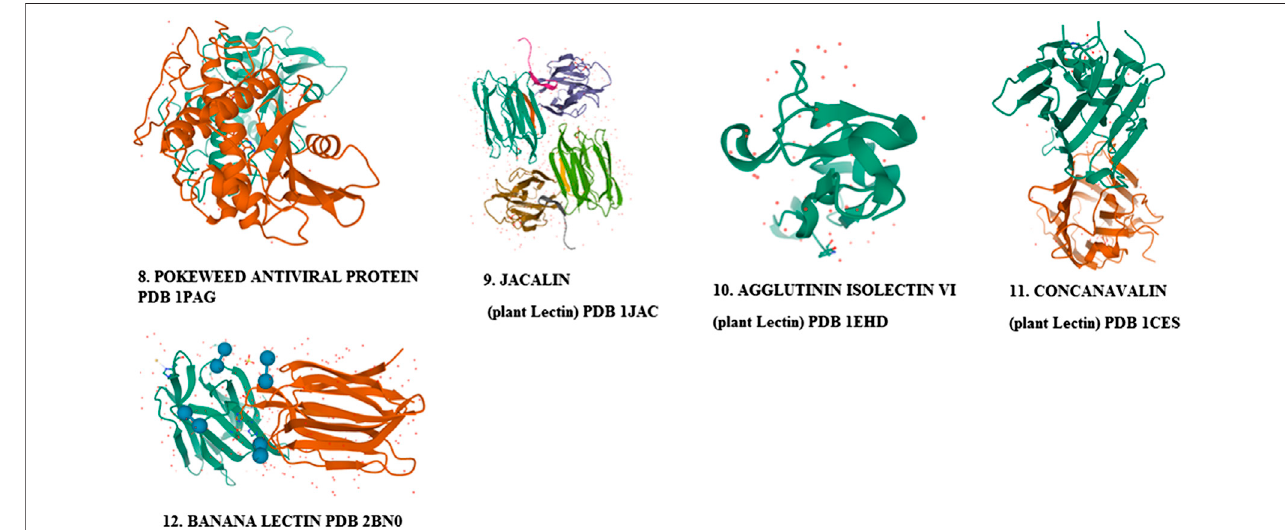
FIGURE 6 | Antiviral proteins isolated from